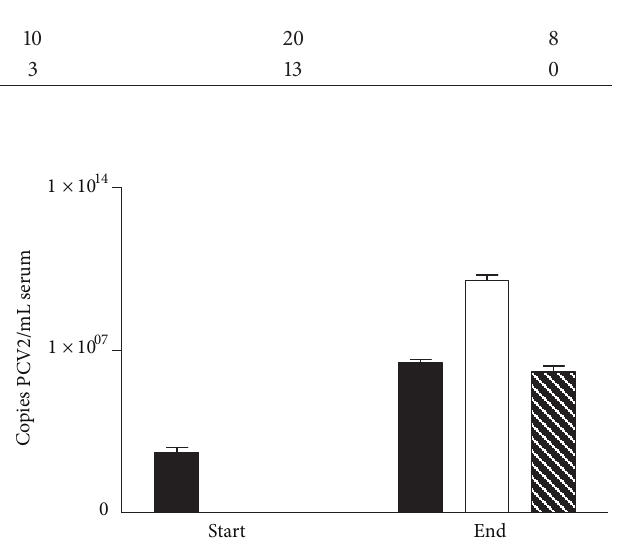
Figure 1: Level of PCV2 in serum (copies per mL of serum) of pigs from PMWS-free herds in unit B (study II) at arrival and at termination of the study. Pigs showing no signs of PMWS (black); pigs with confirmed PMWS (white) and pigs showing signs of PMWS, but which did not fulfil the criteria at necropsy (black and